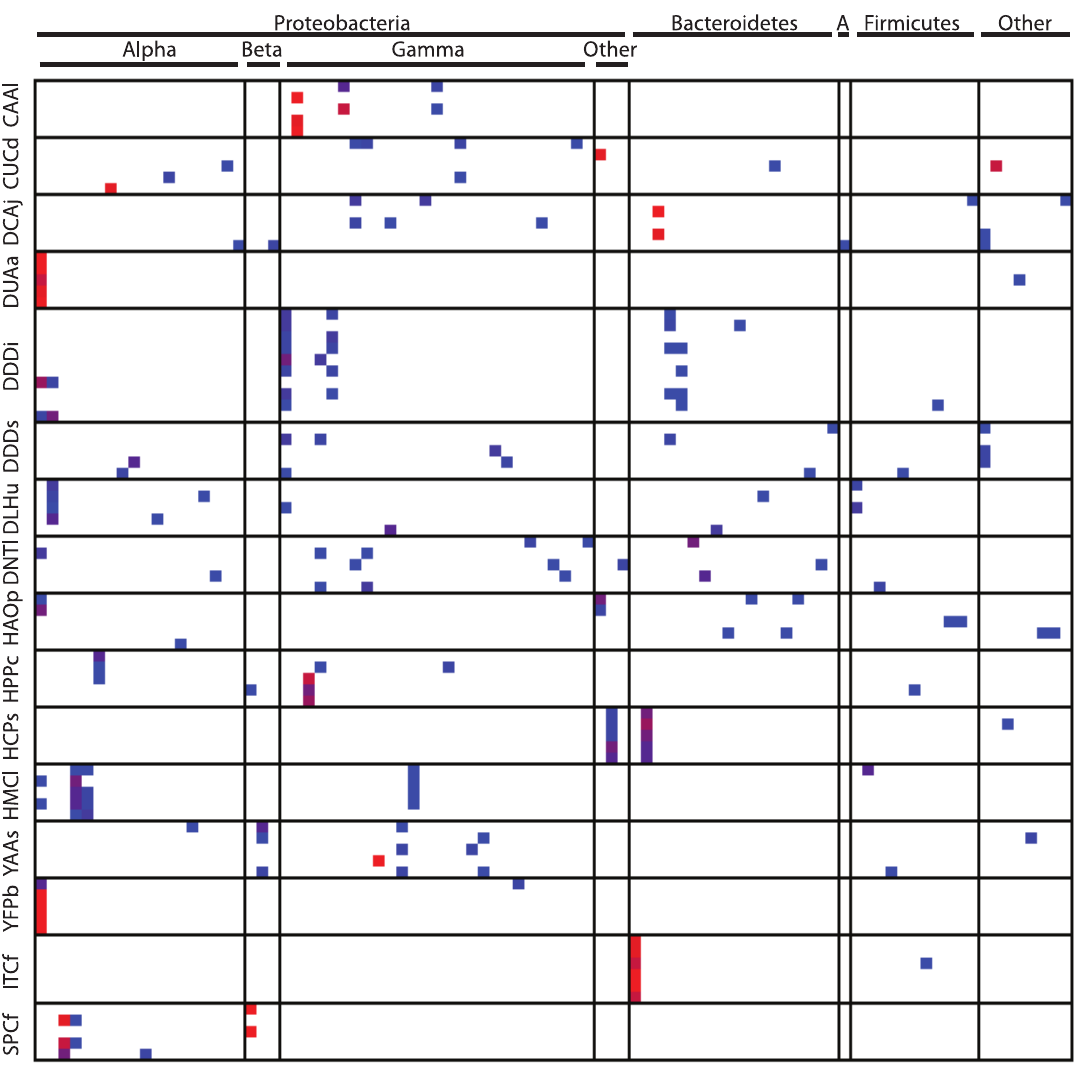
Figure 3. Frequencies of bacterial phylotypes in insect species with at least 5 specimens. Each row is an individual insect specimen and each column is a single bacterial phylotype. Insect codes are detailed in Table 1. Phylotypes with relative abundance of 10% or greater in any one insect are included. Absence of a phylotype within a specimen is indicated by white; relative abundance of a phylotype within a specimen ranges from blue ( . 0%–10%) to red (90%–100%).